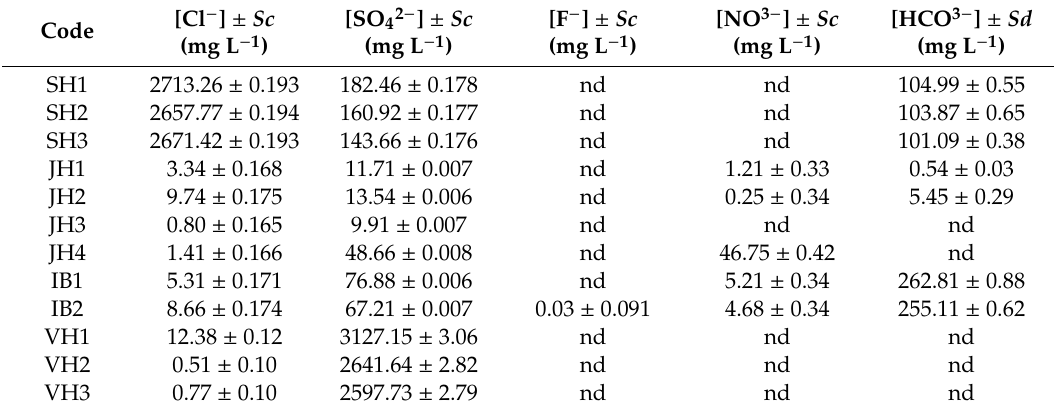
Table 6. Anion concentration of geothermal manifestation in Seulawah Agam mountain.